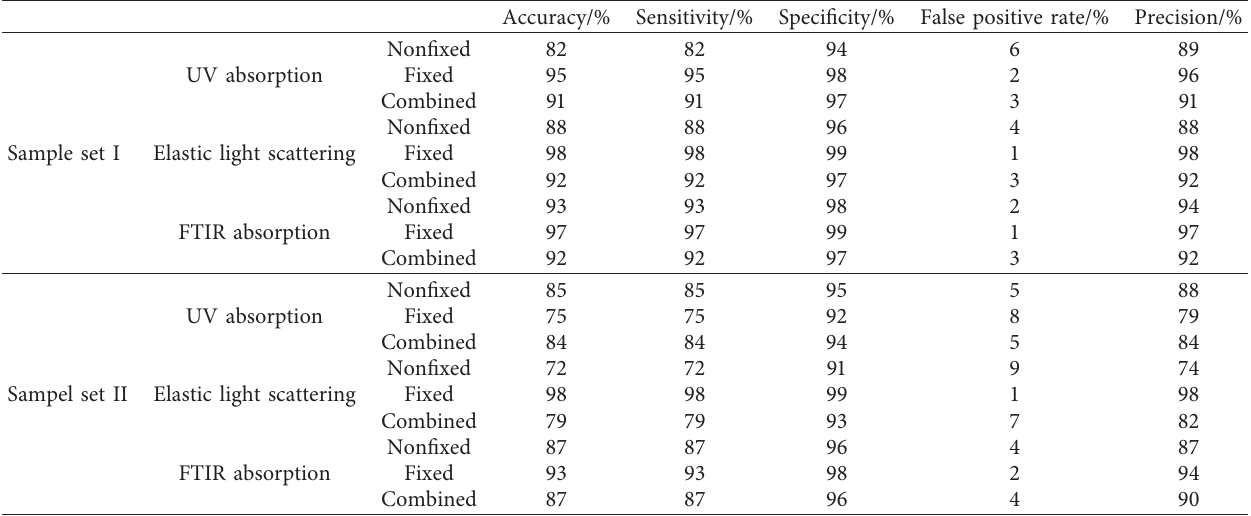
Table 2: Overview of model quality parameters: ccuracy, sensitivity, specificity, false positive rate, and precision are calculated for each method and